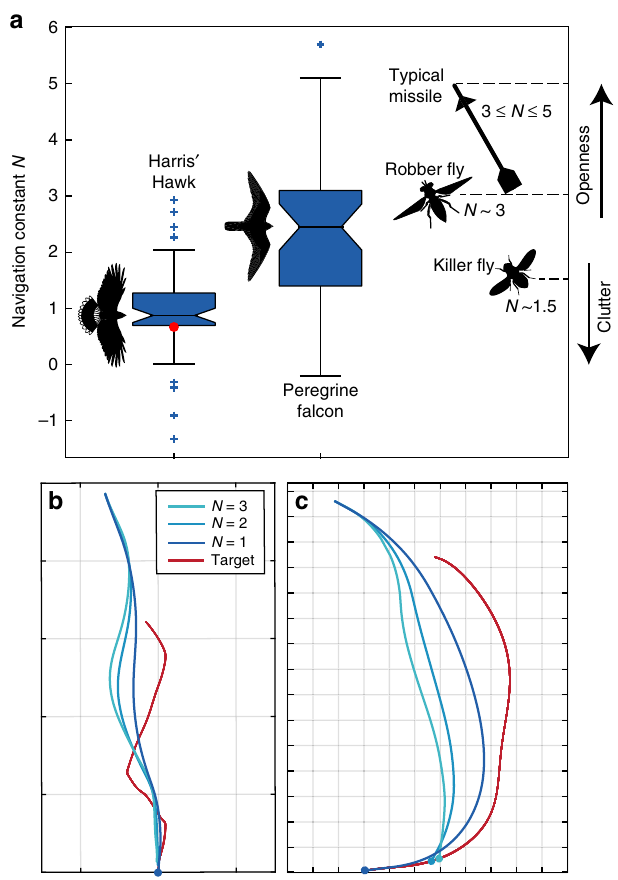
Fig. 6 Comparative analysis of guidance behaviour. a Box-and-whisker plots comparing N -values for PN guidance models fi tted independently to 50 fl ights from Harris ’ Hawks (this paper) and 42 fl ights from Peregrine Falcons 5 . Centre line of box denotes median; bounds of box denote fi rst and third quartiles. Crosses indicate outlying points falling >1.5 times interquartile range below the fi rst quartile or above the third quartile; whiskers extend to the most extreme data points not considered outliers. Red dot denotes N -value for globally fi tted mixed guidance law. Silhouettes show typical values for missiles 6 and predatory fl ies 15,20 . b , c Trajectories simulated under PN guidance at N ∈ {1, 2, 3}, in pursuit of ( b ) jinking ground target from hawk experiments, and ( c ) aerial target from falcon experiments. Initial position of attacker as measured; initial track angle directed at target to avoid bias. Coloured circles denote collision. Grid spacing: 10 m. Fly icons redrawn from original artwork in refs. 15,20 under CC BY